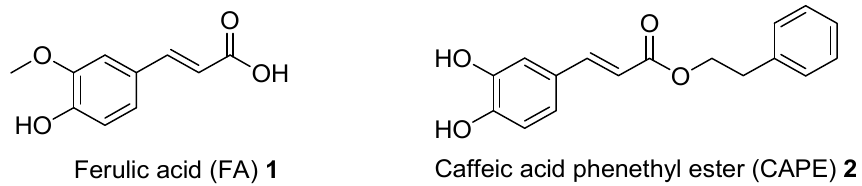
Figure 1. Structure of ferulic acid (FA) 1 and caffeic acid phenethyl ester (CAPE) 2 .